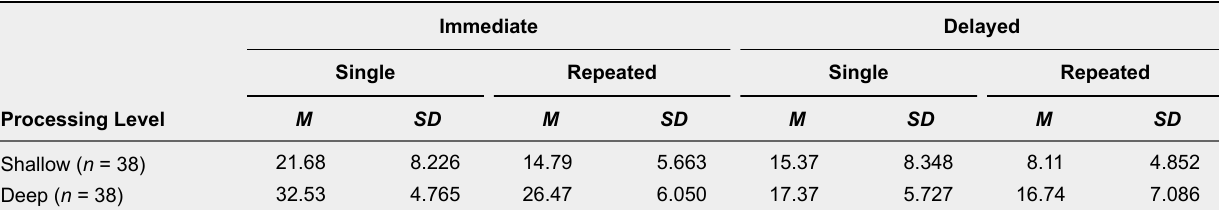
Means and Standard Deviations of the Number of Words (Total = 40) Recalled in Immediate and Delayed Final Recall by Test Trial and Processing Level (N =